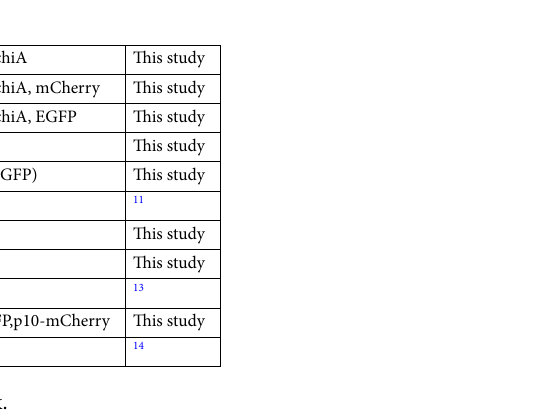
Figure 1. Flowcharts for generation of recombinant viruses and protein production using Tn7-mediated transposition ( a ) or homologous recombination ( b ).